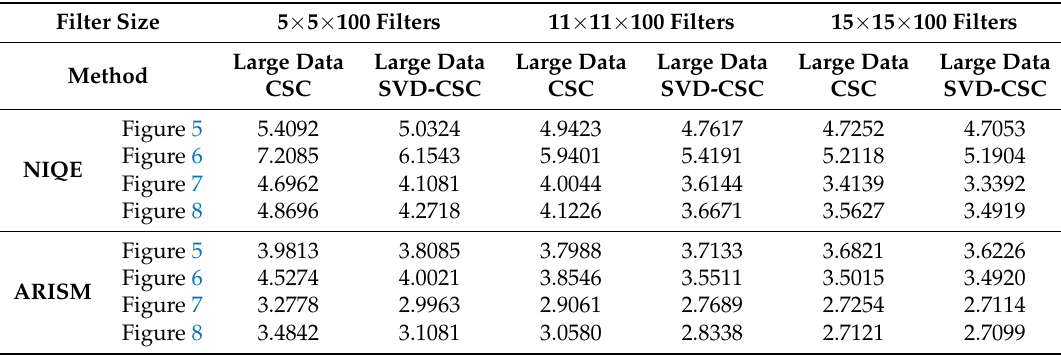
Table 2. Objective evaluation by filter